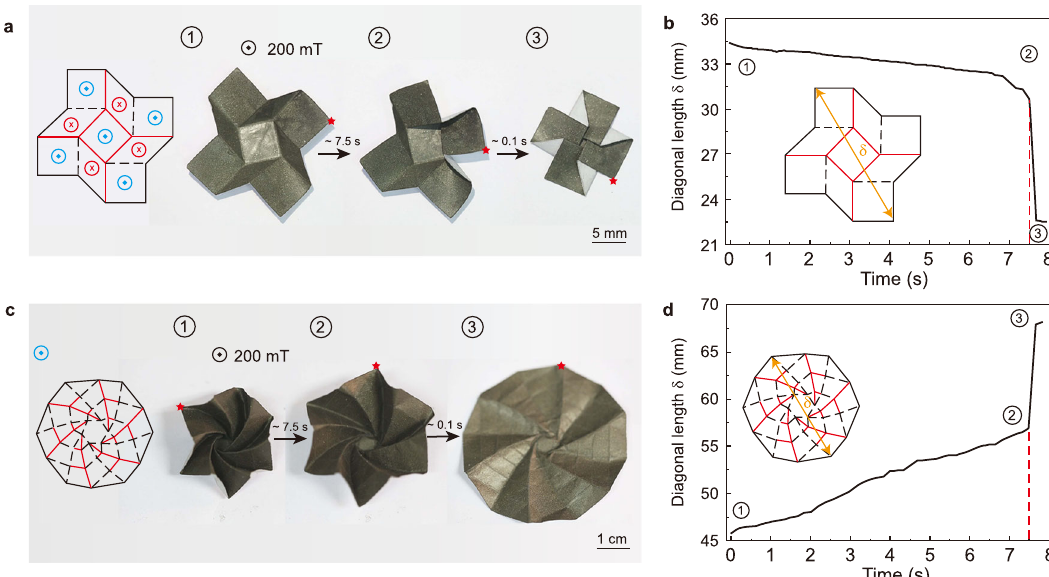
Fig. 3 Folding/unfolding of deployable magneto-origami machines under a magnetic fi eld of 200 mT. a Twisting and folding process of the magneto- origami square – twist that is magnetized at the folded state. b Diagonal length δ of magneto-origami square – twist during the folding process. c The unfolding process of the magneto-origami starshade that is magnetized in the fl at state. The red marker indicates the movement of a marginal point during the deployment process. The blue sign indicates a magnetization pointing outward. d The diagonal length δ of the magneto-origami starshade during the deployment